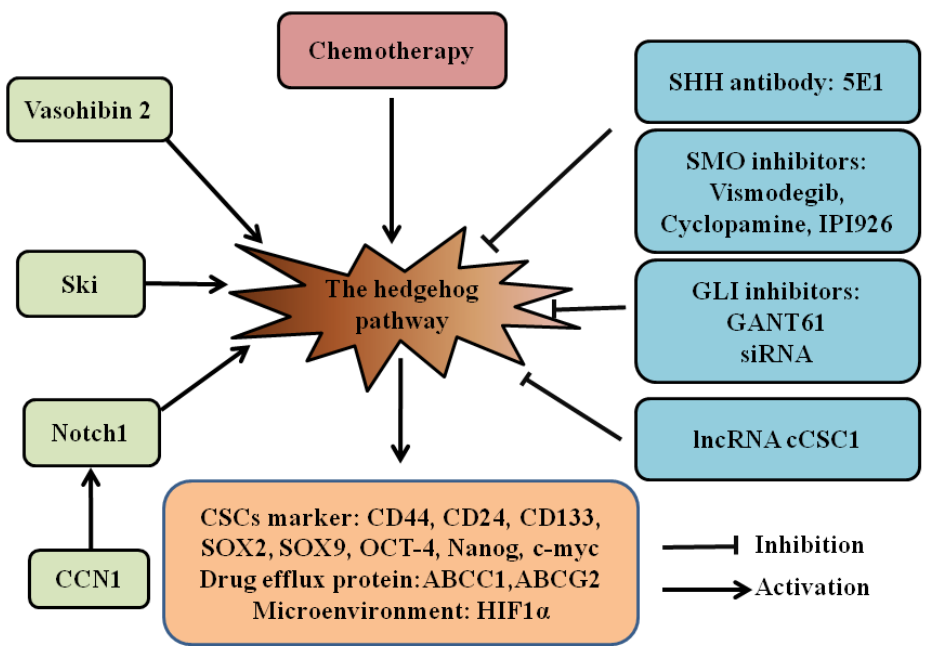
Figure 1. The HH pathway in gastrointestinal CSCs. The role of the hedgehog pathway in drug resistance of gastrointestinal CSCs and inhibitors for hedgehog signaling is summarized. In gastrointestinal CSCs, CCN1, Notch1, Ski, Vasohibin2, and chemotherapy can activate the HH pathway to increase stemness through upregulating CD44, CD24, CD133, SOX2, SOX9, OCT-4, Nanog, and c-myc, to increase drug resistance by elevating the expression of the drug efflux protein ABCC1 and ABCG2, and to adapt to hypoxia via high expression of HIF1 α . The HH inhibitors (5E1, vismodegib, cyclopamine, IPI926, GANT61, GLI siRNA, and lncRNA cCSC1) can attenuate these processes. Hedgehog (HH); cancer stem cells (CSCs); cellular communication network factor 1 (CCN1); ATP- binding cassette subfamily C member 1 (ABCC1); ATP-binding cassette subfamily G member 2 (ABCG2); hypoxia inducible factor 1 α ( HIF1α ).